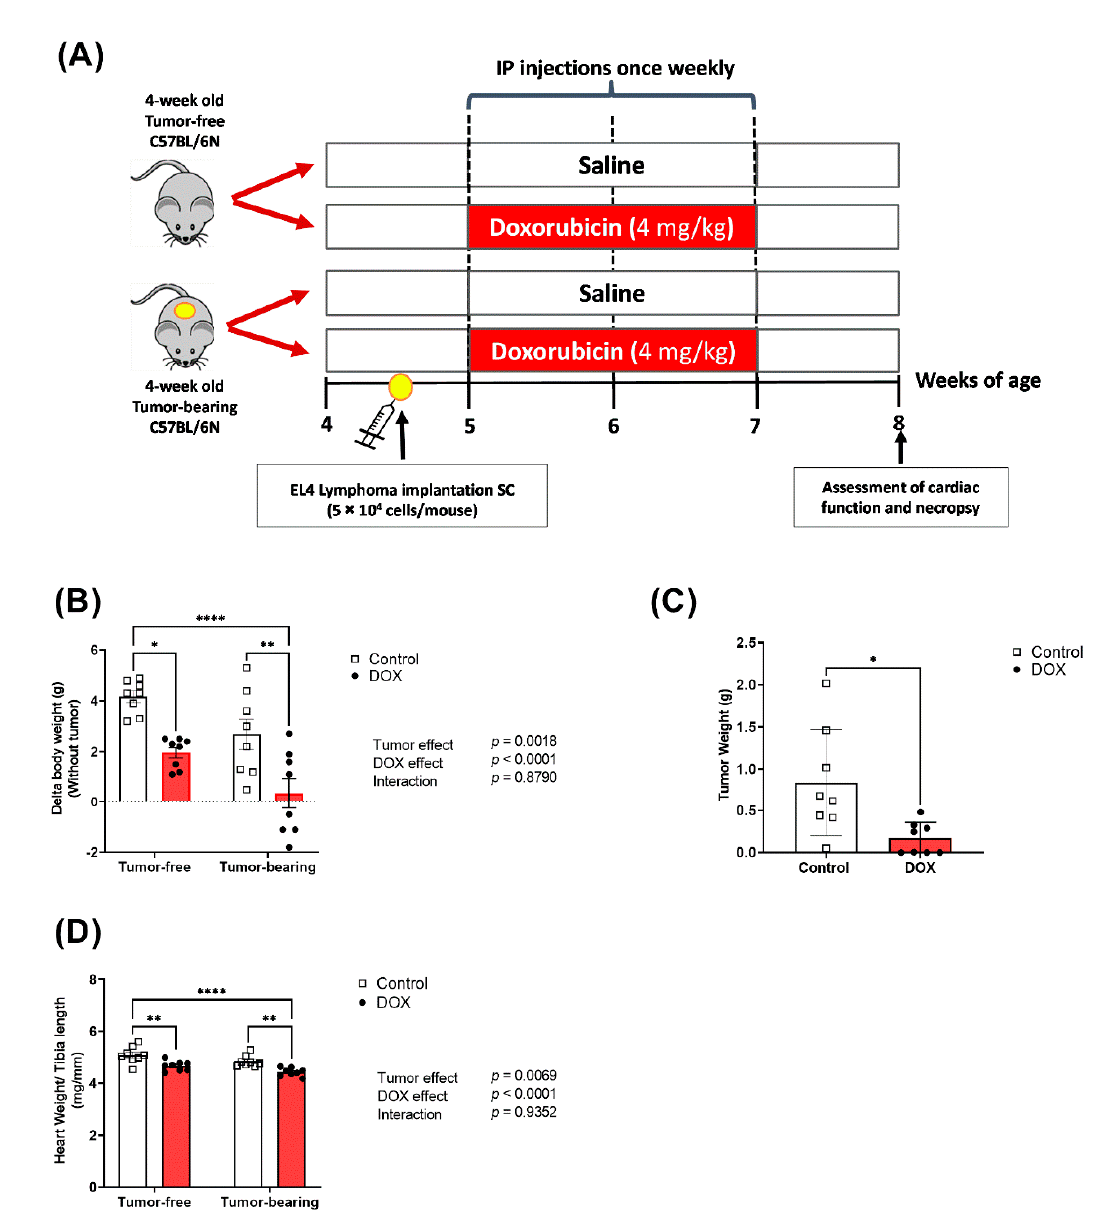
Figure 1. Model schematic diagram and body weight data. ( A ) Scheme of the experimental study design to investigate the effects of low dose DOX in EL4 lymphoma tumor-bearing C57BL/6N juvenile mice. One week following administration of intraperitoneal (IP) DOX (4 mg/kg/week) or equivalent volume of saline for 3 weeks, the final body weight with and without tumors was recorded, and ( B ) the change from baseline body weight was calculated ( n = 8 per group); ( C ) tumors were harvested and weighed ( n = 8 per group); ( D ) hearts were harvested from both tumor-free and EL4 lymphoma tumor-bearing mice one week following the administration of 4 mg/kg/week of DOX or equivalent volume of sterile saline for 3 weeks and hearts weights (mg) were measured and normalized to the tibial length (mm) (HW/TL) ( n = 8 per group). Two-way ANOVA table demonstrates DOX, tumor, and interaction effects. Statistical significance of pairwise comparisons was determined using two-way ANOVA with Tukey’s post hoc analysis. Tumor weights were compared using unpaired Student’s two-tailed t -test. (* p < 0.05, ** p < 0.01, and **** p < 0.0001).